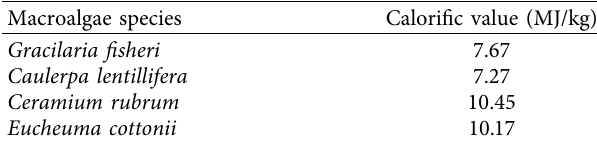
Table 5: Calorific value of macroalgae selected